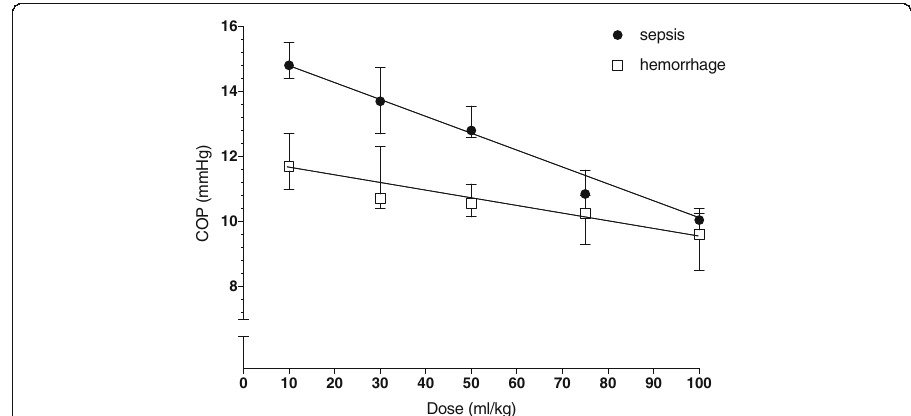
Fig. 5 Plasma oncotic pressure at 60 min after completion of resuscitation. Differences in dose-dependent decrease in plasma oncotic pressure between the two groups were analyzed by comparing the slope of the dose – response curves as calculated by linear regression. ( P < 0.001 for the difference in slope using linear regression with an interaction